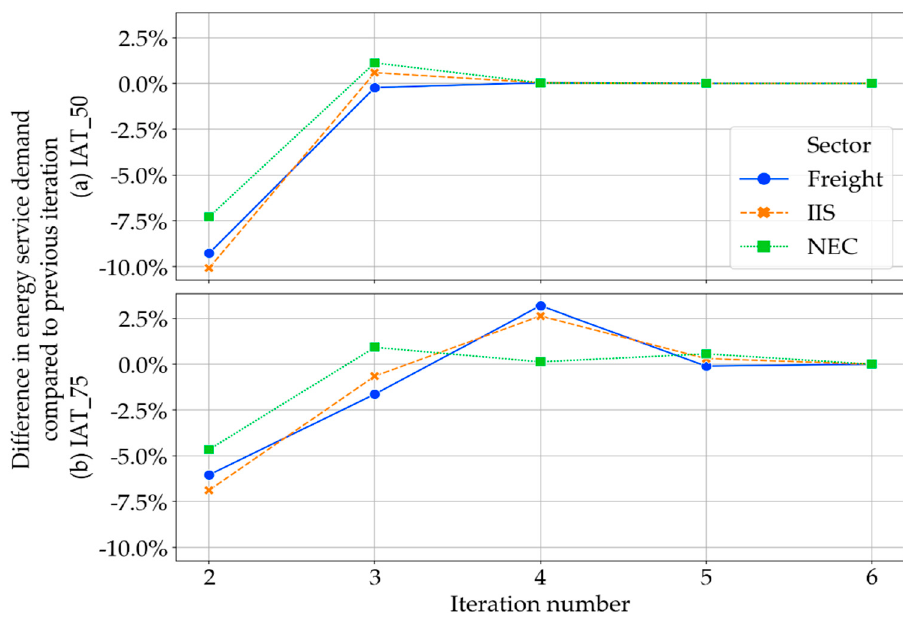
Figure 7. Difference (%) in the selected energy service demand developments in the EU28 compared to previous iteration for (a) IAT_50 and (b) IAT_75 in 2050.